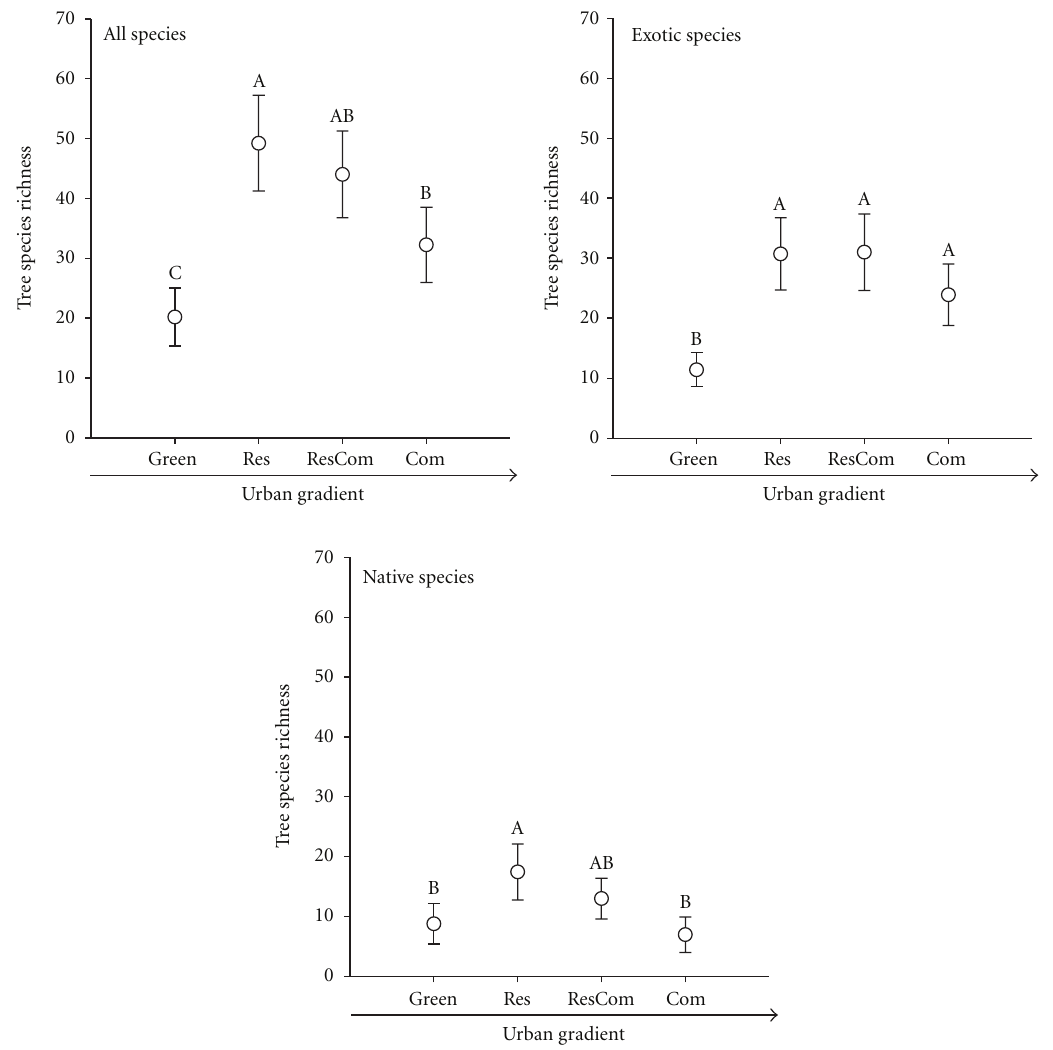
Figure 2: Computed tree species richness for the studied urban land uses. Values represent average values ( ± 95% confidence intervals) computed at 524, 281, and 243 individuals for total, exotic, and native species, respectively. Letters represent statistical di ff erences. Green: green areas, Res: residential areas, ResCom: residential-commercial areas, Com: Commercial